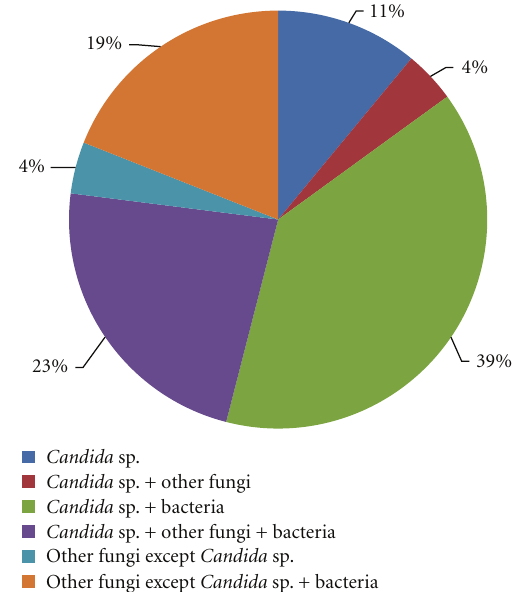
Figure 2: Percentage distribution of di ff erent mastitis aetiological agents isolated from milk samples.